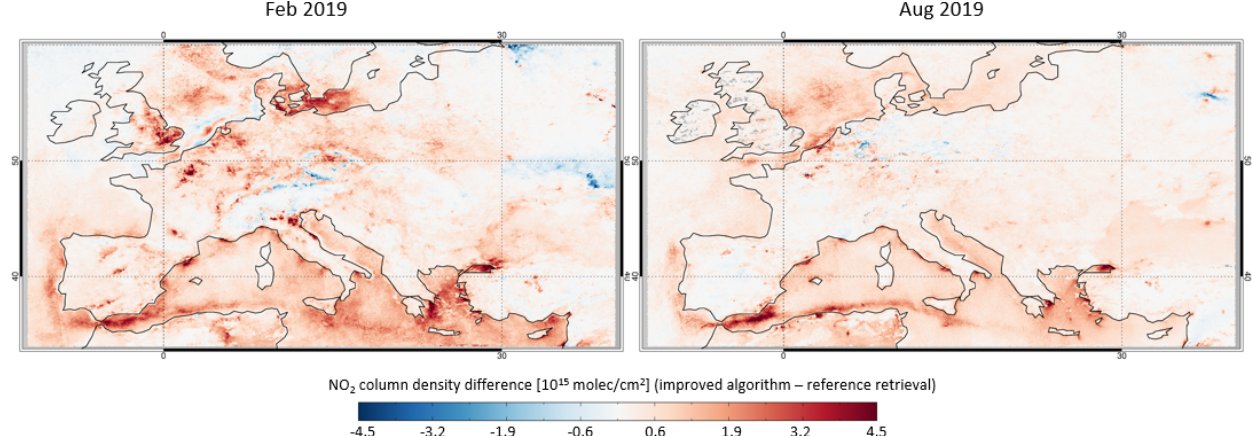
Figure 19. Differences in the tropospheric NO 2 columns retrieved using the reference algorithm and improved algorithm over Europe in February and August 2019. Only measurements with a cloud radiance fraction less than 0.5 are included.